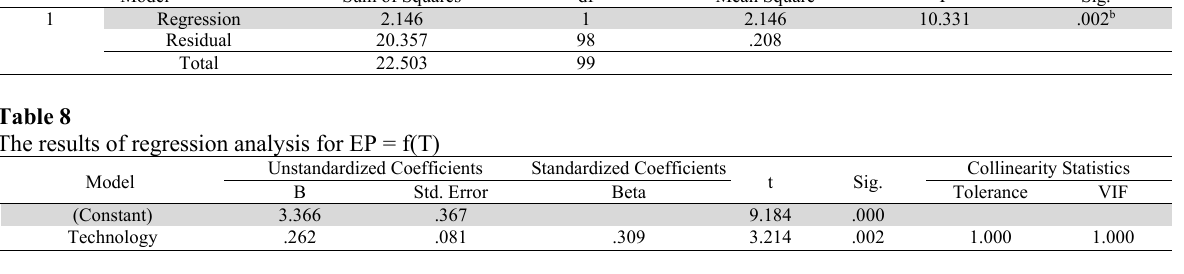
The results of ANOVA test for EP =f(T) Model